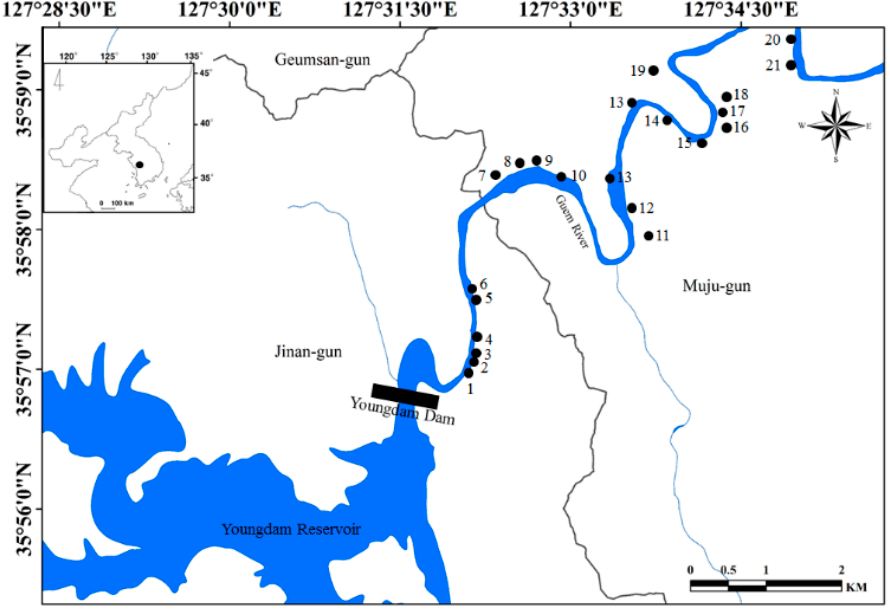
Figure 1. Map of the study sites located upstream of the Geum River. The study sites are indicated by solid circles ( ● ). The small map in the upper left corner shows the Korean peninsula.